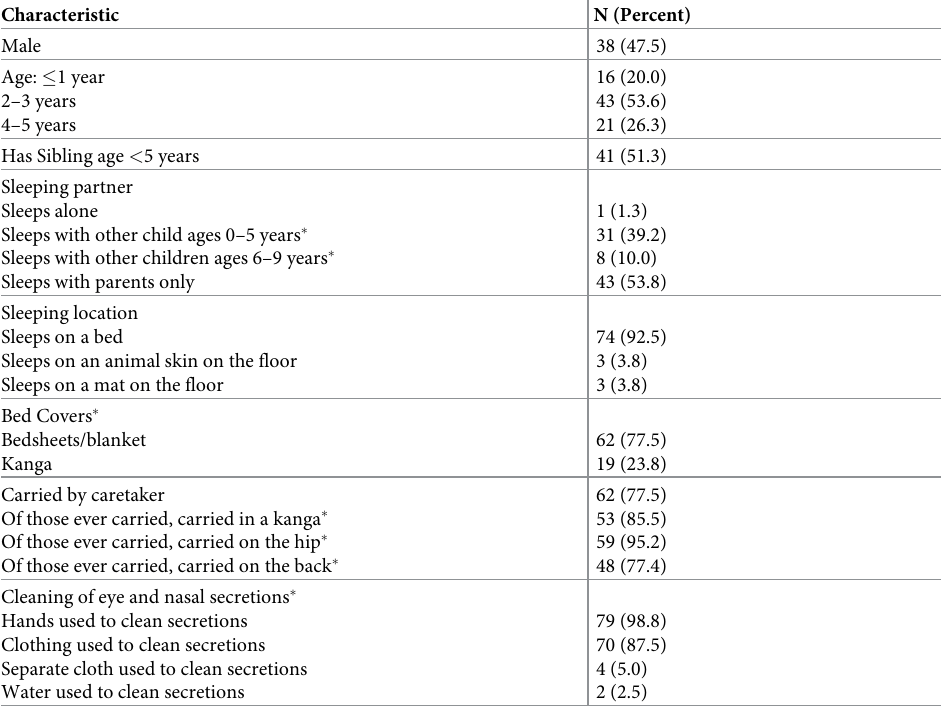
Table 2. Characteristics of children examined (n =